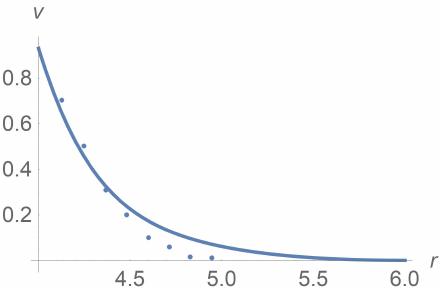
Figure 7. The solid line corresponds to dimensionless velocity profile versus the radial variable for Ω = 5[rpm] and φ = 0.1. Dots stand for experimental data [9].